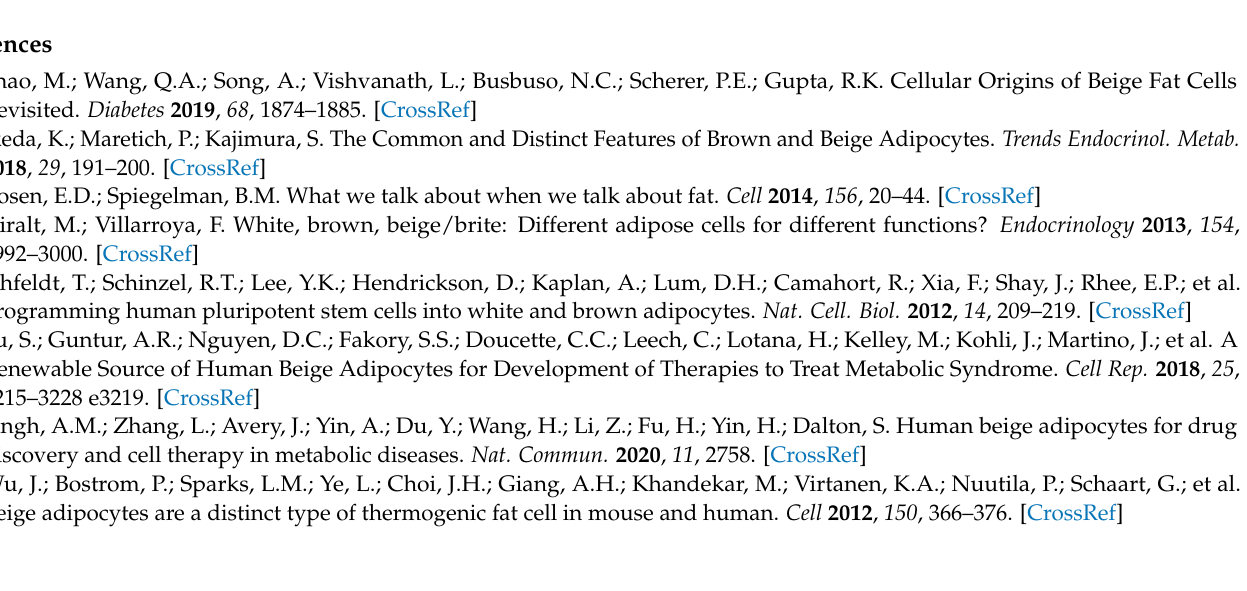
Table S2: List of 1376 genes specifically downregulated in beige adipocytes, Table S3: The primers for